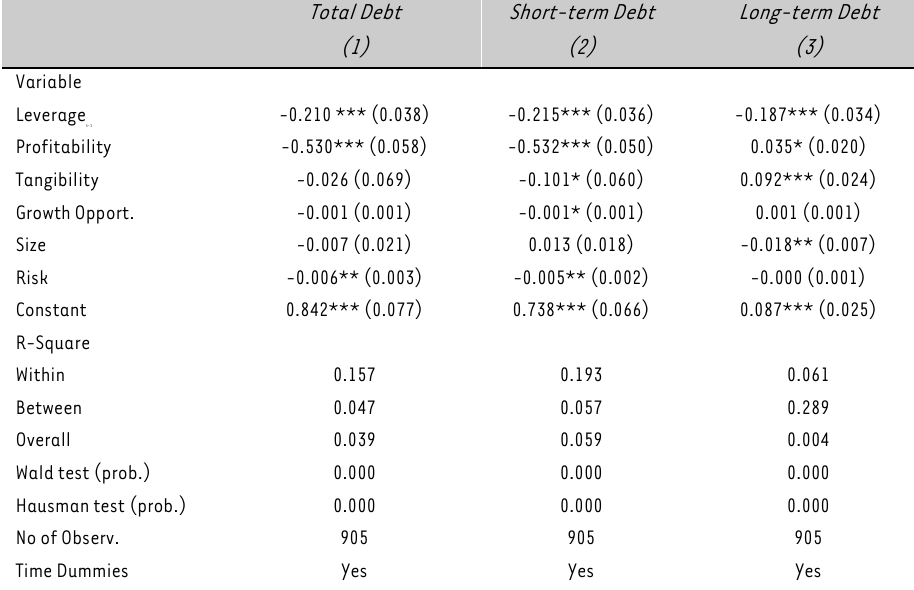
Panel fixed effects estimation